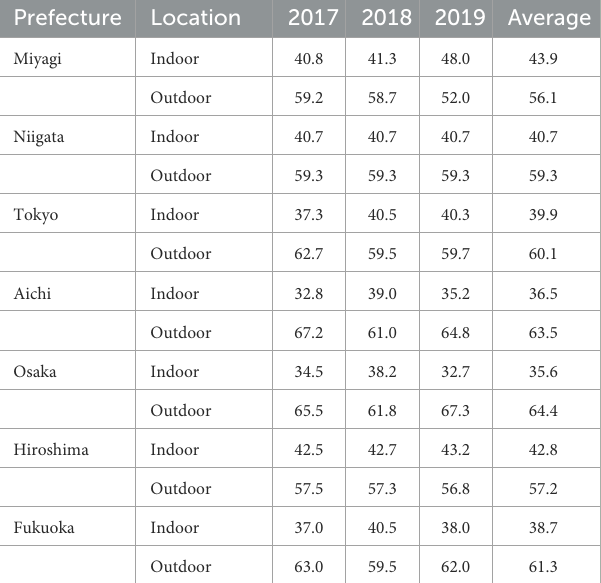
[five-year age intervals; n = 1 (20–24 years old), ...,14 (85 years old and over)]; P ( n ) denotes the age composition of population in each prefecture. The function be cn + d is the regression curve derived in Figure 4 in Kodera et al. (19) expressed the increase in the risk of heat-related illness with age; the parameters b ( = 0.171), c ( = 0.494), and d ( = 190.7) determined by the least-squares fitting method, based on the age components of heat illness patients in Japan. Equation (4) represents the short-term heat adaption during the summer, i.e., the risk of heat-related illnesses k (coefficient